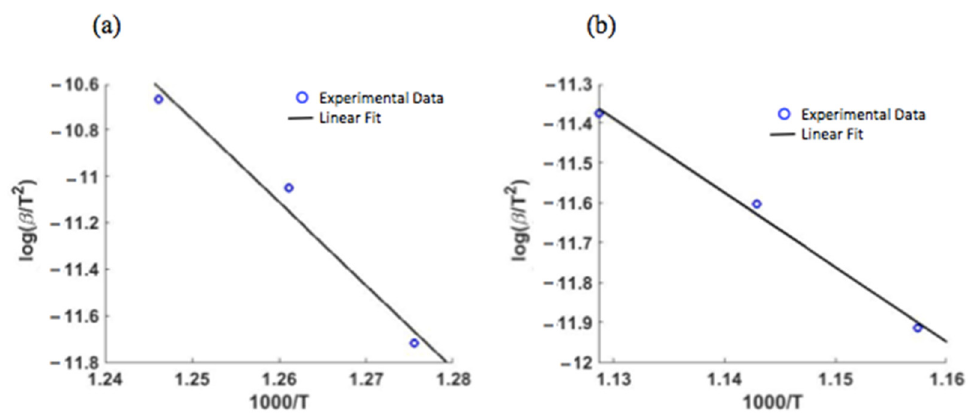
Figure 7. Kissinger data line for ( a ) SWCNT samples and ( b ) MWCNT samples. Blue circles indicate dataset derived from the peak temperature of the DSC thermograph, and the black line is linear fit of the experimental data.